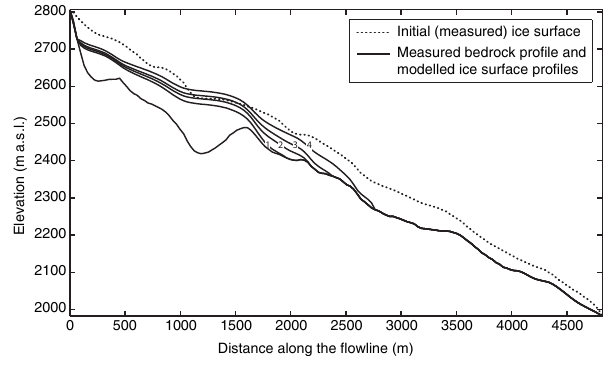
Fig. 8. Steady-state glacier profiles simulated for prescribed net balances of (1) − 0 . 78m w.e., (2) − 0 . 71m w.e., (3) − 0 . 635m w.e., and (4) − 0 . 47m w.e. The structure of the balance profile follows the solid black curve in Fig. 3. A = 2 . 4 × 10 − 24 Pa − 3 s − 1 , m max = 0 . 25 and λ max = 6m in all simulations.